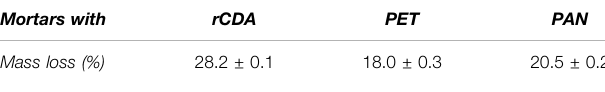
TABLE 2 | Binder leakage stability results of asphalt mortars with different fi